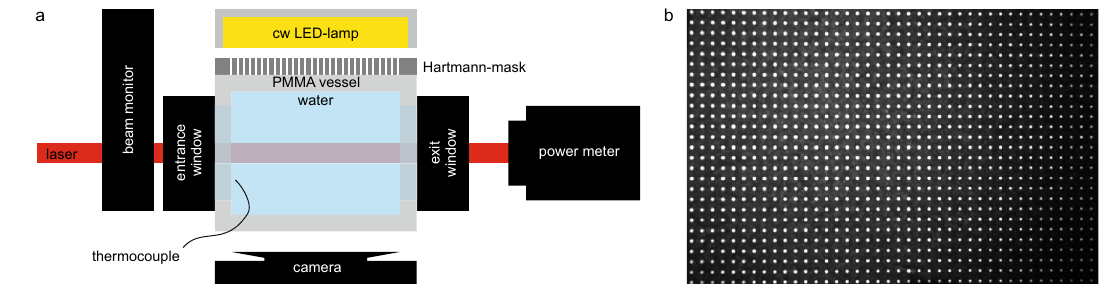
Figure 1. ( a ) Experimental setup for measuring the transmission of laser light in water and the refractive index changes. The laser spot shape was measured in front of the water vessel via a beam monitor, while the transmitted power was determined with a power meter. For imaging the transmitted intensity distribution, the power meter was replaced by an aluminium plate as scattering screen (tilted by 45 and was imaged with a camera. The temperature increase in the water was detected with a thermocouple. The wavefront distortion was measured with a custom-made Hartmann-mask detector consisting of a LED-lamp, a rectangular spot pattern screen ( b ) and a camera imaging the spot